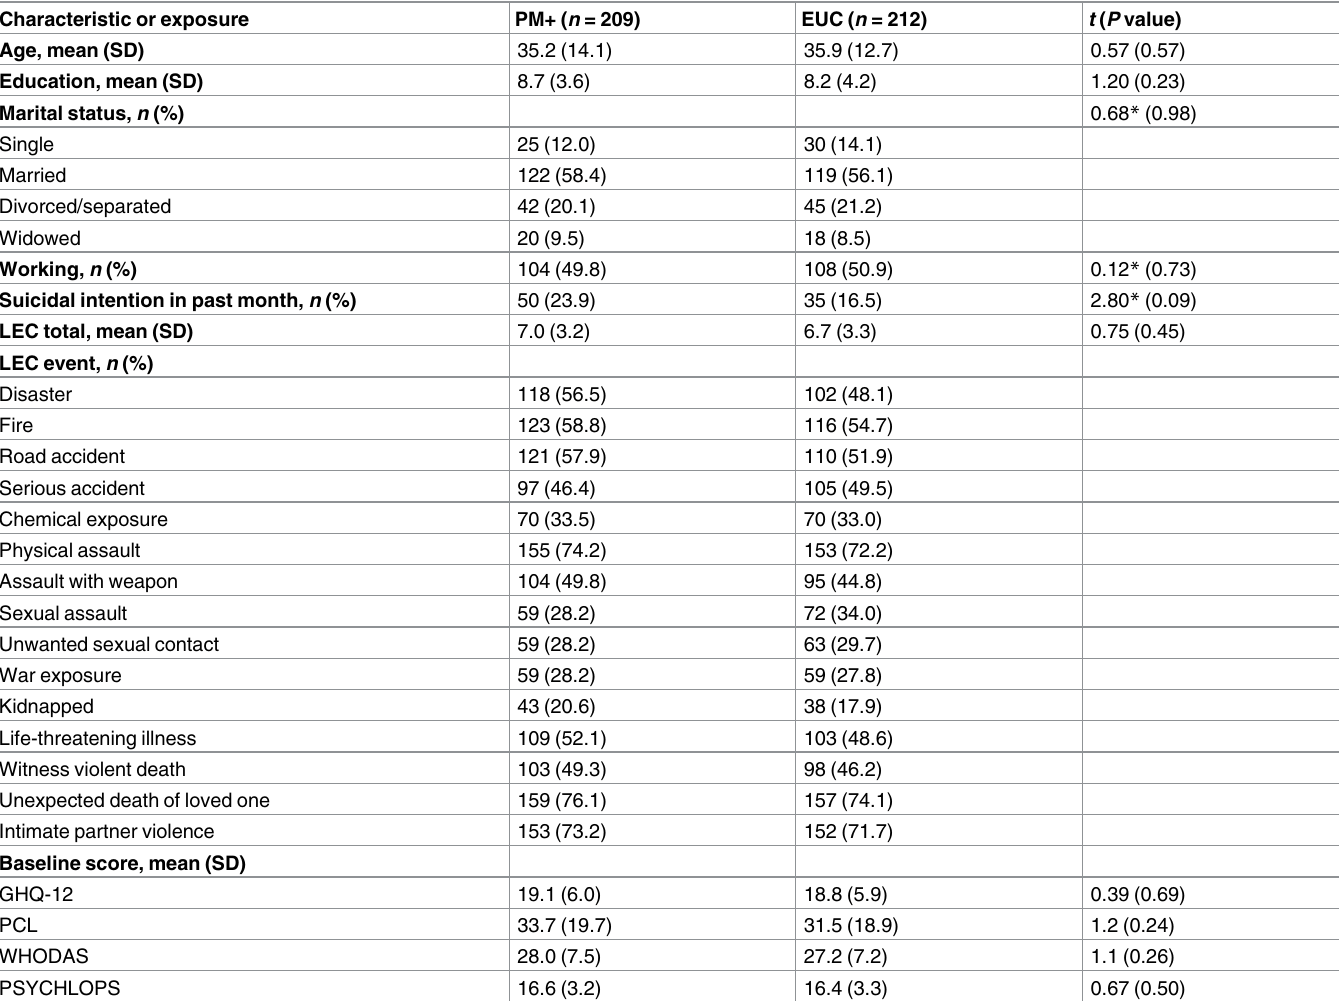
Table 1. Participant characteristics and trauma exposure assessedat